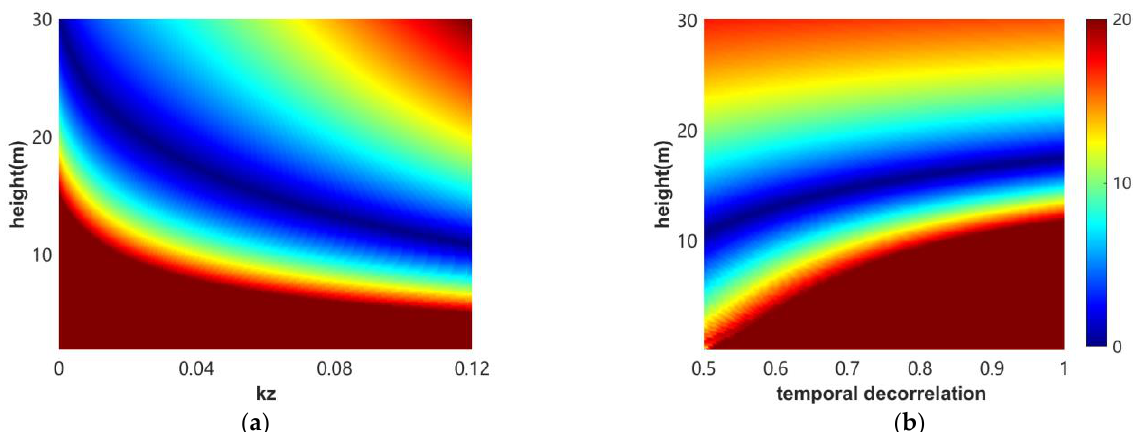
Figure 16. The forest height is relative to the retrieved the error and is defined as (|ℎ | ℎ ⁄ ) × 100% , with a range of 0% to 20%. ( a ): The fixed temporal decorrelation is 0.98, 𝑣 − ℎ 𝑡𝑟𝑢𝑒 𝑡𝑟𝑢𝑒 and the error of the tree height of 0 – 30 m when 𝑘 𝑧 is 0 – 0.12 is analyzed. ( b ): Fix 𝑘 𝑧 = 0.1 and analyze the error variation of the 0 – 30 m tree height in the range of 0.5 – 1 for temporal